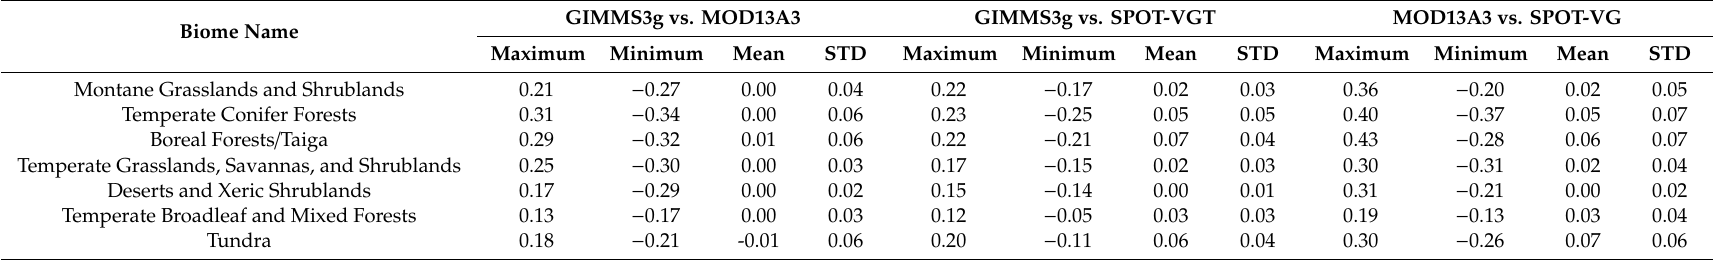
Table 4. Zonal statistic results of the MBE values between the three NDVI products over the seven biomes of the